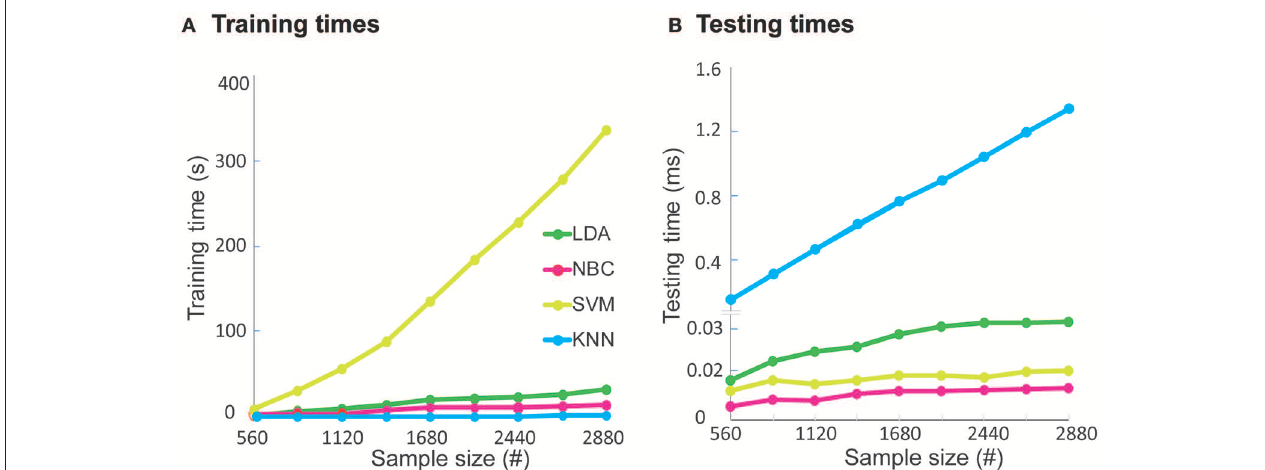
FIGURE 4 | Algorithm (A) training times and (B) testing times on sample dataset. The dataset is comprised of 2,880 primitives. We computed times to train and test each algorithm on 20–100% of the dataset in increments of 10%. To avoid overfitting and compute an unbiased estimate of training and testing times, ML algorithms were trained and tested de novo with each incremental increase. For training with the complete sample dataset, SVM required the most time (336s) while the other algorithms finished training rapidly ( < 30s). For testing, KNN required the most time (1.5ms), while the other algorithms finished testing rapidly ( < 0.03ms). Please note break in the y-axis to highlight the difference in the algorithm testing times.